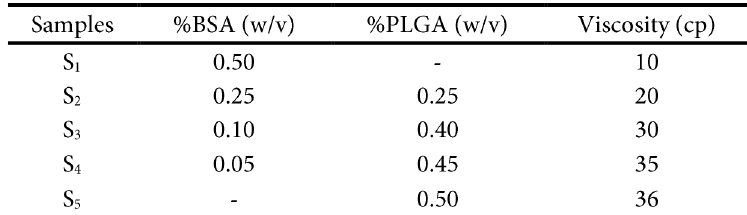
Table 1. Physical properties of PLGA/BSA